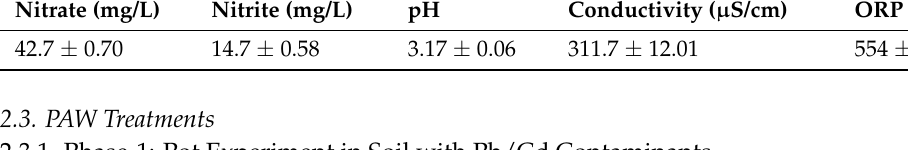
Figure 1. ( A ) The PAW generation system consisting of two plasma jet electrodes, RO water supply, power supply, and air supply. ( B ) The PAW treatment of seeds. Table 1. The physiochemical properties of PAW.